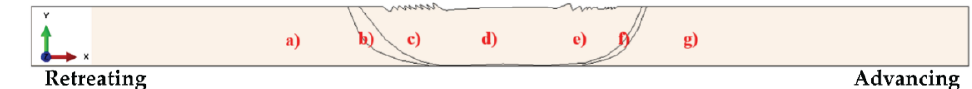
Figure 6. Prescribed locations for the microstructure taken for comparison. a, and g represent base material; b, and f represent TMAZ on RET, and ADV side; c, and e represent locations inside the weld nugget, however, closer to TMAZ on RET, and ADV side; d, represents locations in